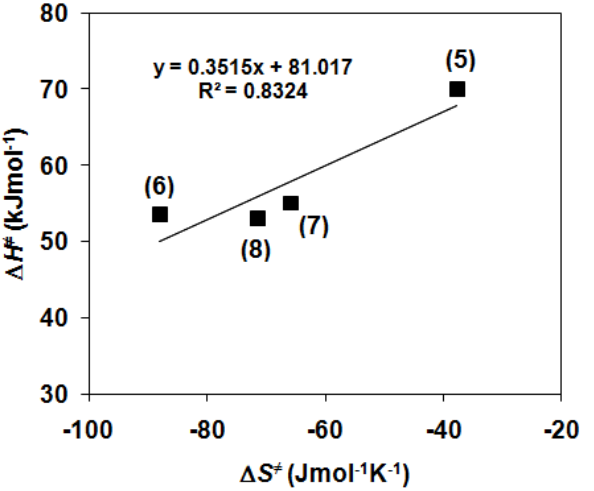
Figure 8. Isokinetic plot for the for the Fe III 2 ( µ -O)( µ -1,2-O 2 )(L 1–4 ) 2 (Solv) 2 ] 2+ ( 5 – 8 )-mediated dispro- portionation of H 2 O 2 in CH 3